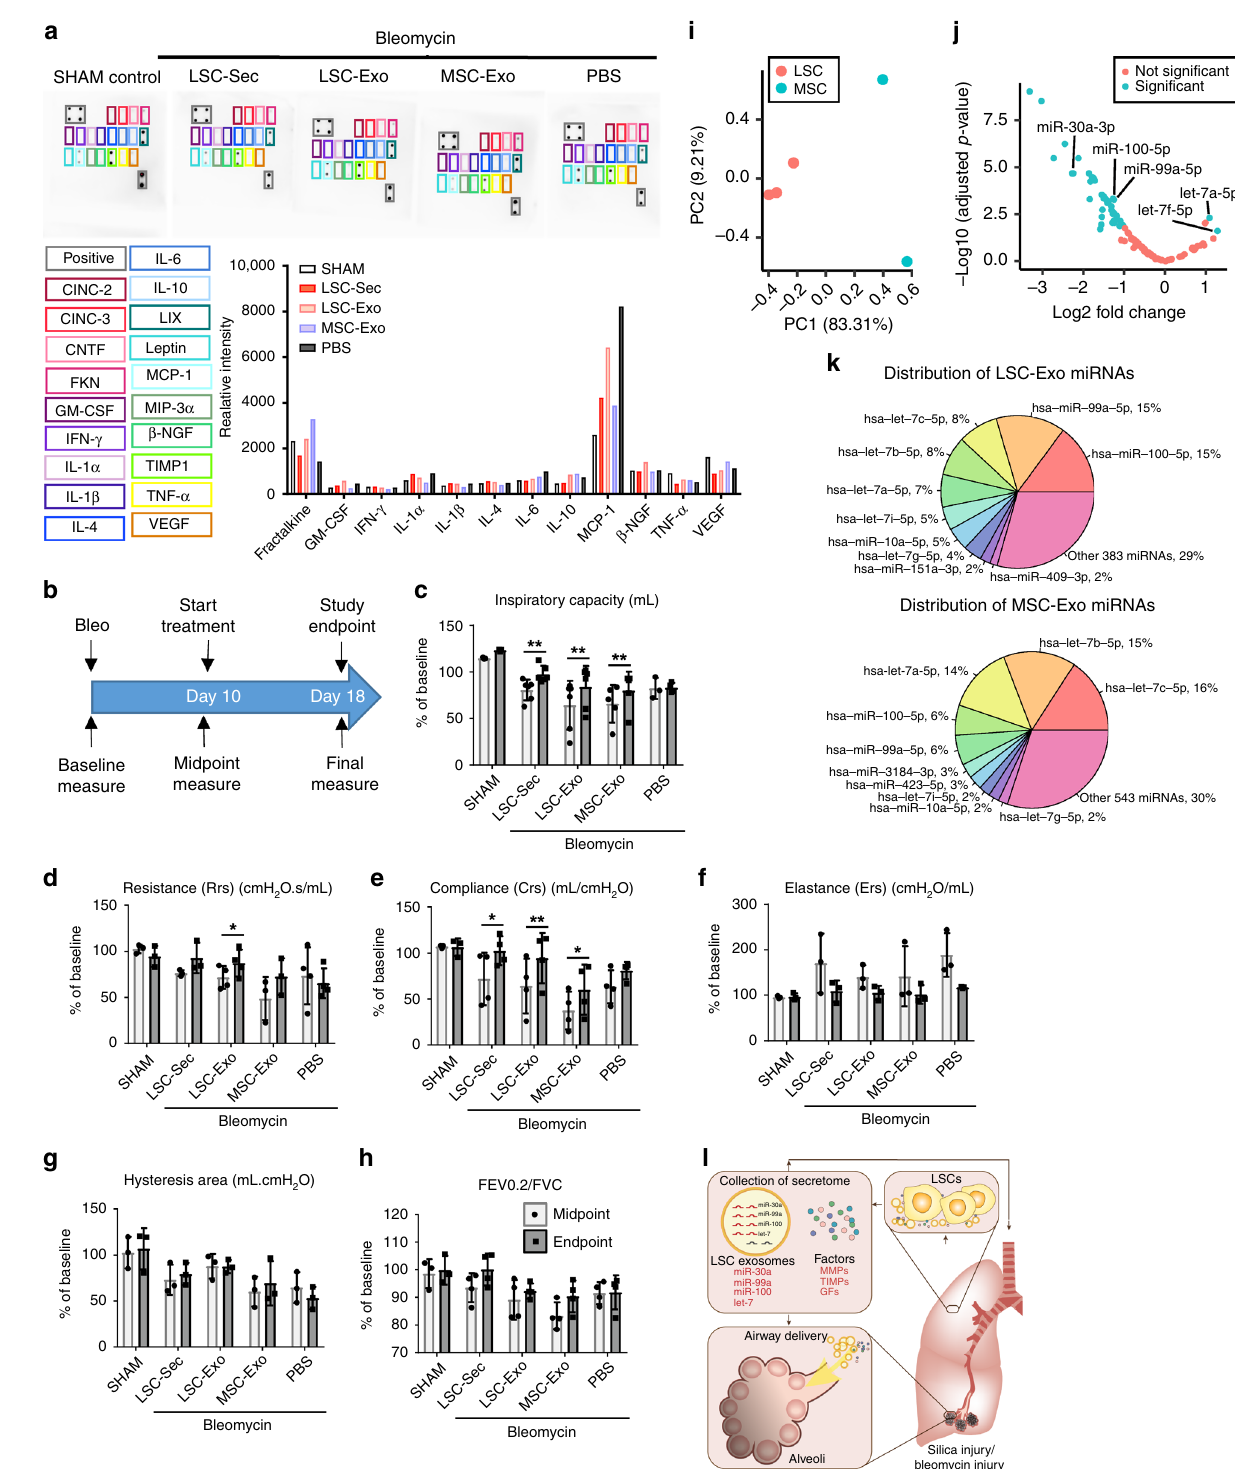
Fig. 6 Exosome treatment improves pulmonary function post-Bleo and exosome miRNA pro fi ling. a Representative rat cytokine array detecting 19 rat proteins from blood serum. b The schematic of pulmonary function measurements. c – g Quanti fi cation of lung function measurements ( c ) pulmonary inspiratory capacity; ( d ) pulmonary elastance ( e ) pulmonary resistance; ( f ) pulmonary compliance; ( g ) hysteresis area; ( h ) forced expiratory volume (FEV) to forced vital capacity (FVC) ratio. i Principal component analysis chart of LSC-exosome and MSC-exosome microRNA content. j Volcano plot of differentially expressed miRNA of LSC-exosomes and MSC-exosomes miRNA content. k Distribution of the top 10 miRNAs in LSC-exosomes (top) and MSC-exosomes (bottom). l LSC secreted exosomes and soluble factors modulate alveolar repair and fi brosis. Throughout, data are mean ± s.d. P -value as indicated by non-parametric one-way ANOVA ( a ) and Student ’ s paired t -test ( c – h